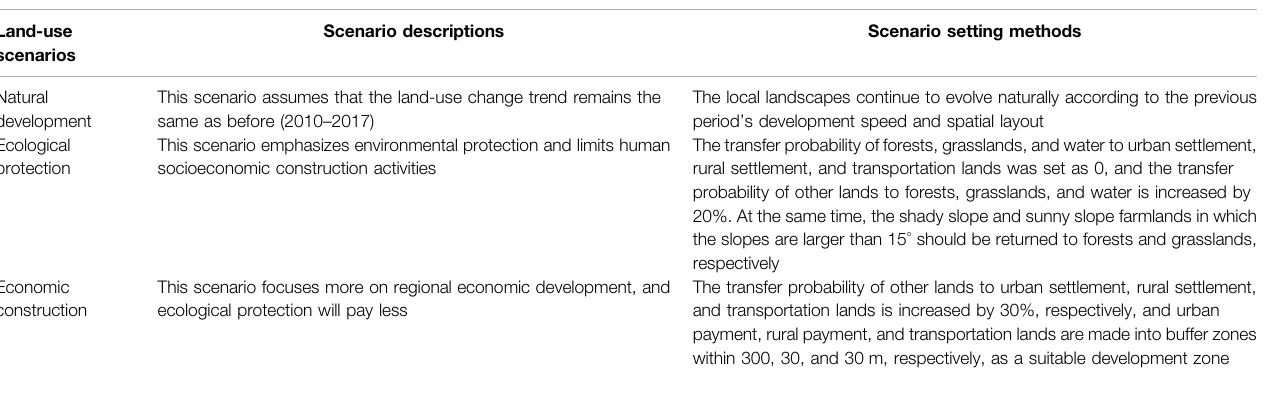
TABLE 1 | Brief introduction of the three scenarios on land-use simulation. Land-use